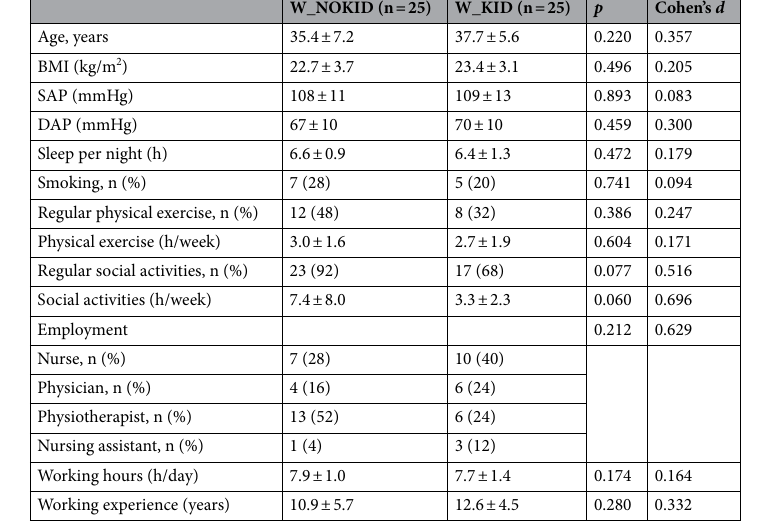
Table 1. Demographic and clinical features of the enrolled population. W_NOKID, women without preschoolers; W_KID, women with at least one preschooler; BMI, body mass index; SAP, systolic arterial pressure; DAP, diastolic arterial pressure; p , type I error probability; Cohen’s d , Cohen’s standardized mean difference between groups. Data are presented as mean ± standard deviation or number